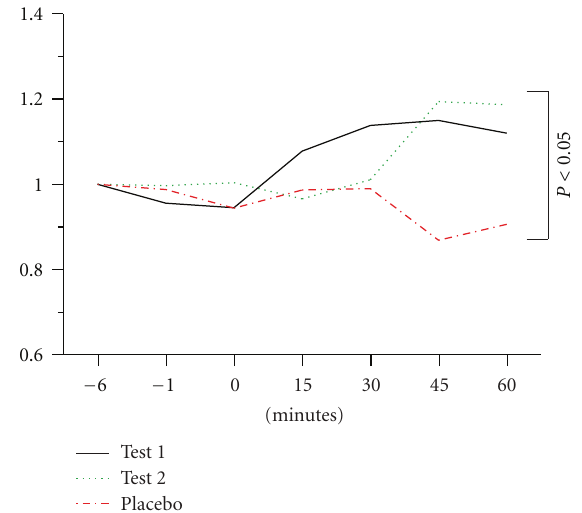
Figure 4: Changes in the ratios of the maximum pinching muscle force before and after TMS with MVC under the test 1, test 2 or placebo condition. Values show averaged ratios to the maximum pinching force in the first session of TMS with